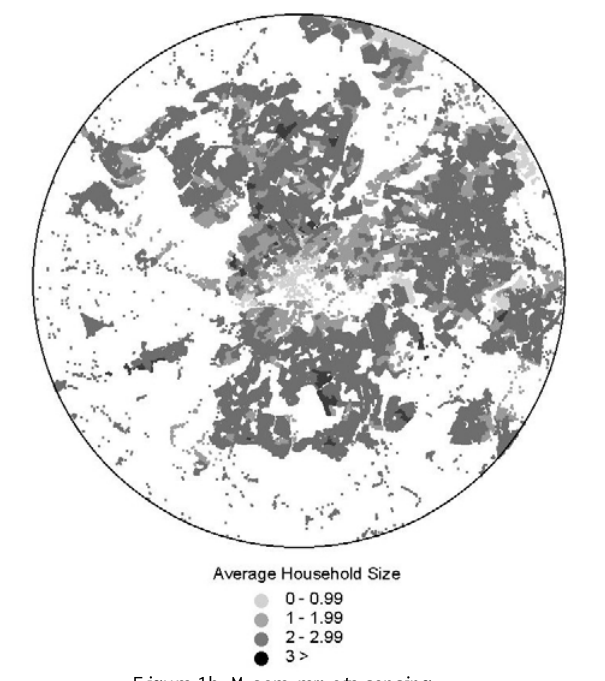
Figure 1b: Macro remote sensing. Landsat TM image classified into residential land use and linked by dasymetric mapping to population census to calculate average household size (Bristol,